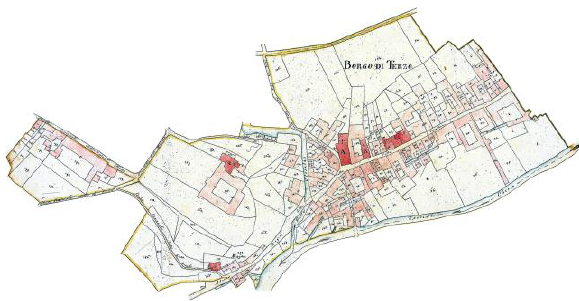
Figure 09. Borgo di Terzo – Ancient cadastral map (1853)